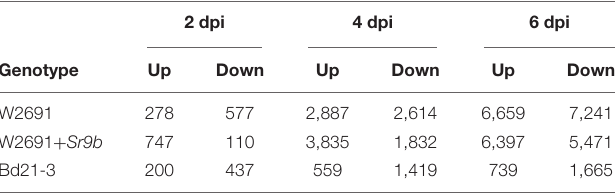
TABLE 1 | Differentially expressed genes in T. aestivum and B. distachyon in response to P. graminis f. sp. tritici infection. 2 dpi 4 dpi 6 dpi